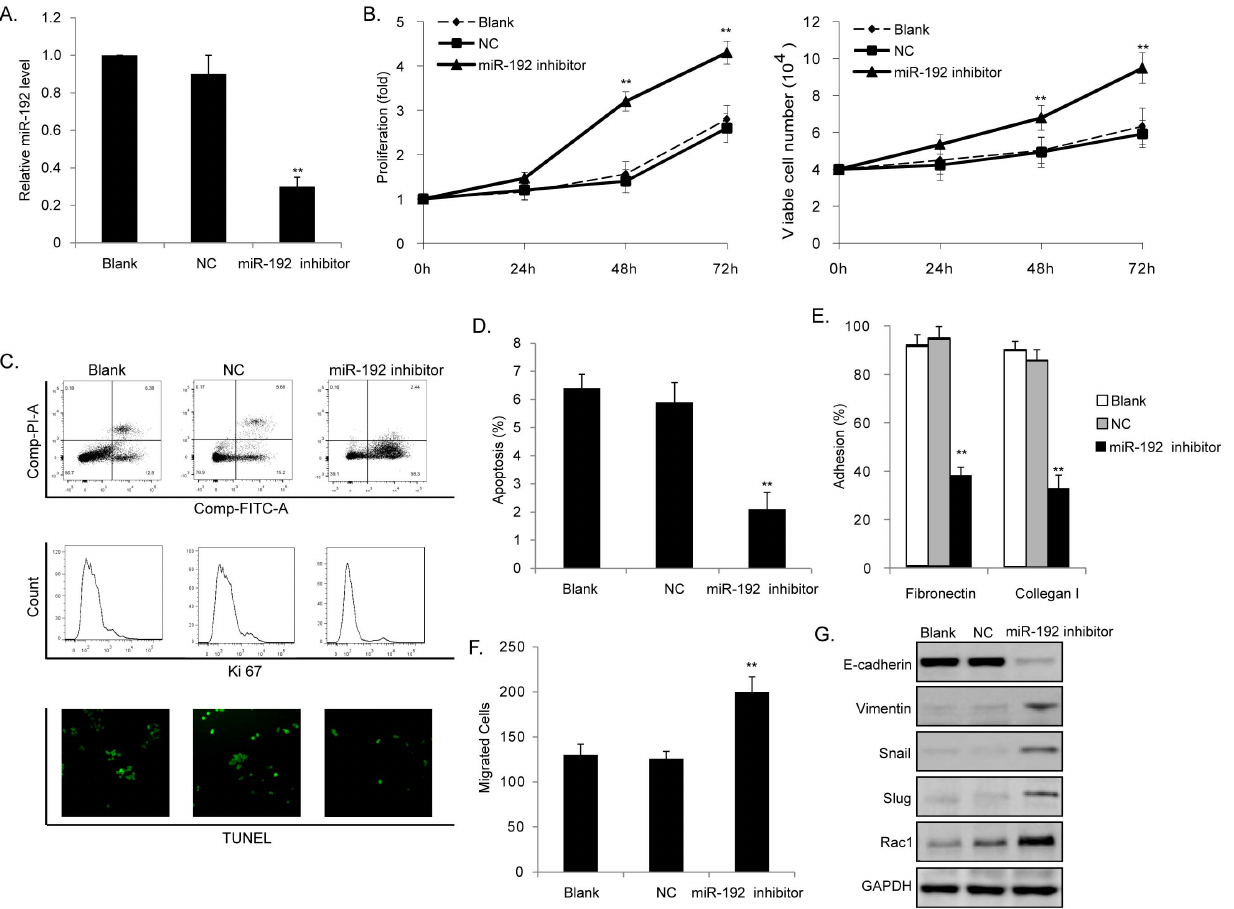
Fig. 3. Loss of miR-192 mimicked the effects of IL-17 on MM cells. (A) Downregulation of miR-192 in MM1S cells was induced by transfecting cells with miR-192 inhibitor. (B) Loss of miR-192 induced cell proliferation. (C) Loss of miR-192 repressed cellular apoptosis. (D) Canonical histogram of apoptotic rate characterized by Annexin-FITC positive cells was shown. (E) Loss of miR-192 decreased cell adhesion to fibronectin and collagen I. (F) Loss of miR-192 promoted cell migration. (G) Loss of miR-192 induced EMT and Rac1 expression of cells. (**P , 0.01, *P , 0.05, Figure is representative of 3 experiments with similar